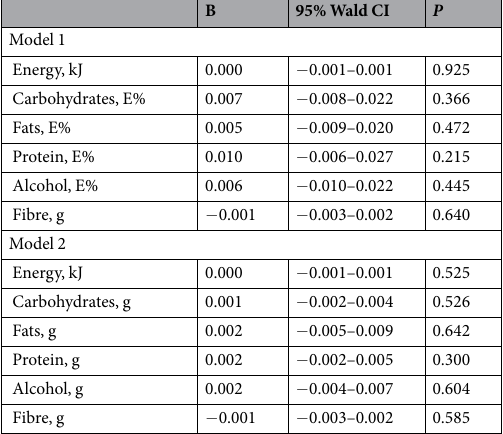
Table 4. Associations between dietary intake (energy, macronutrient, and fibre intake) and serum LPS activity in 542 individuals. kJ, kilojoule; E%, percentage of total energy intake. Data on energy and nutrient intakes have been obtained from the food records. Both models have been adjusted for sample storage time, age, sex, smoking, physical activity, and diabetic nephropathy status. Generalized linear